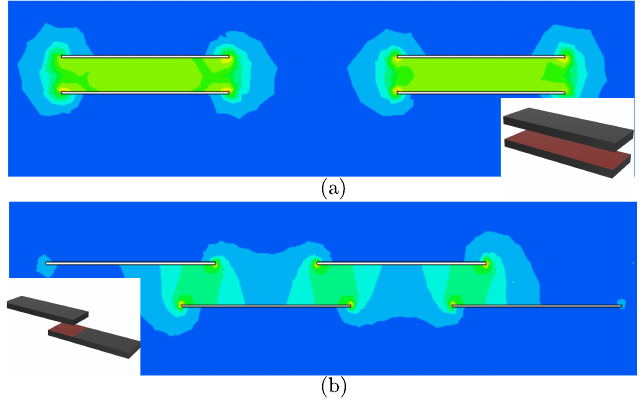
Figure 17. Effective common surface area between two tracks and comparison of FEM results for ( a ) non-shifted, and ( b ) two-layer-shifted structures. The shifting of layers reduces the trapped energy between them [17].